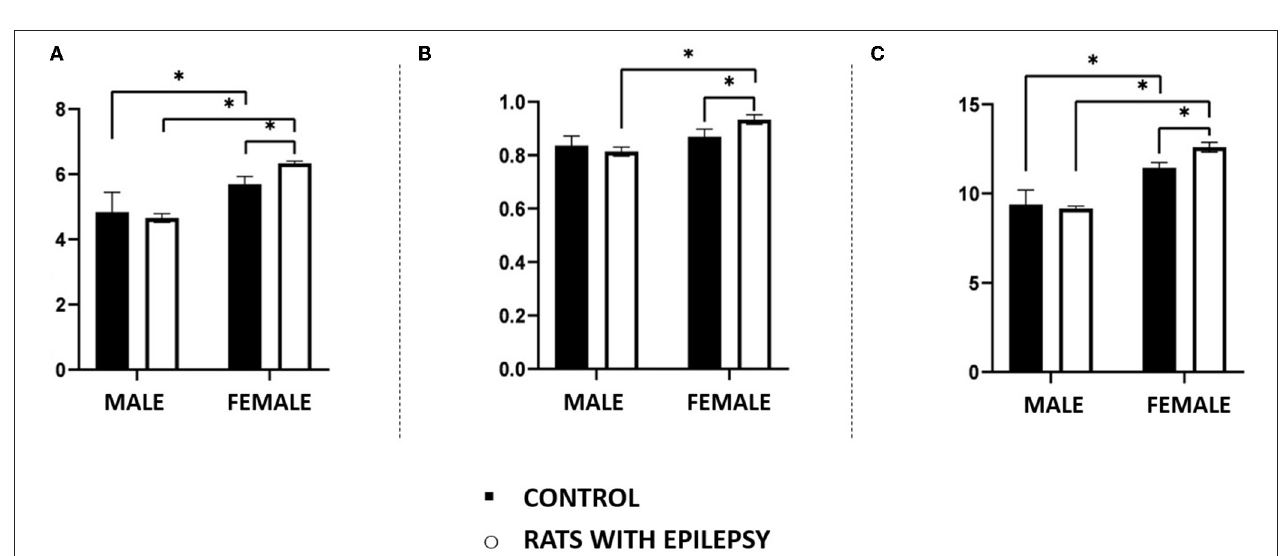
FIGURE 5 | Number (in millions) of non-neuronal cells in the hippocampus (A) , amygdala (B) , and olfactory bulb (C) of male and female rats submitted to the pilocarpine model of epilepsy compared to that observed in respective controls. Data are expressed as mean ± SD. Data from rats with epilepsy were compared with those of their respective controls using two-way ANOVA followed by Tukey’s post-hoc test. * p <